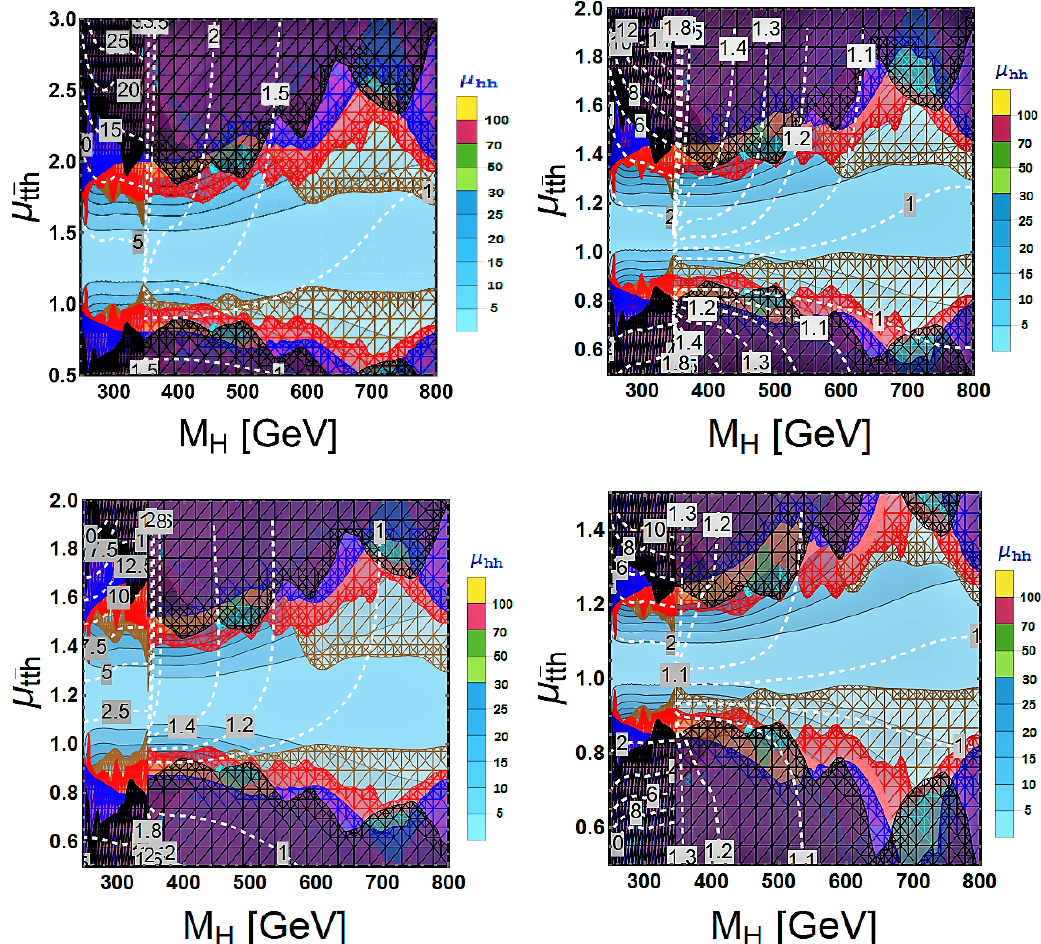
Figure 12 . Contour plot of (cid:22) Zh and (cid:22) hh in (cid:22) -M H plane. The scaling of (cid:22) hh is shown on right side t (cid:22) th of the each (cid:12)gure, whereas the boxed numbers for the dashed contours indicate di(cid:11)erent values of (cid:22) Zh . Black, pink and cyan colored meshed zones are excluded parameter space from current di-Higgs limit looking at di(cid:11)erent (cid:12)nal states b (cid:22) b(cid:13)(cid:13); b (cid:22) bb (cid:22) b and b (cid:22) b(cid:28) + (cid:28) (cid:0) respectively; red, blue and brown meshed zone is the excluded parameter space from the resonant ZZ , W + W (cid:0) and Zh production constraints. We have used a typical set of parameters (sin( (cid:11) (cid:0) (cid:12) ) = 0 : 5 ; ~ Y b = (cid:0) 0 : 09 ; ~ Y (cid:28) = 10 (cid:0) 3 ) for top left; (sin( (cid:11) (cid:0) (cid:12) ) = 0 : 3 ; ~ Y b = (cid:0) 0 : 09 ; ~ Y (cid:28) = 10 (cid:0) 3 ) for top right; (sin( (cid:11) (cid:0) (cid:12) ) = 0 : 4 ; ~ Y b = 0 : 02 ; ~ Y (cid:28) = 10 (cid:0) 3 ) for bottom left and (sin( (cid:11) (cid:0) (cid:12) ) = (cid:0) 0 : 2 ; ~ Y b = 0 : 04 ; ~ Y (cid:28) = 10 (cid:0) 3 ) for bottom right.